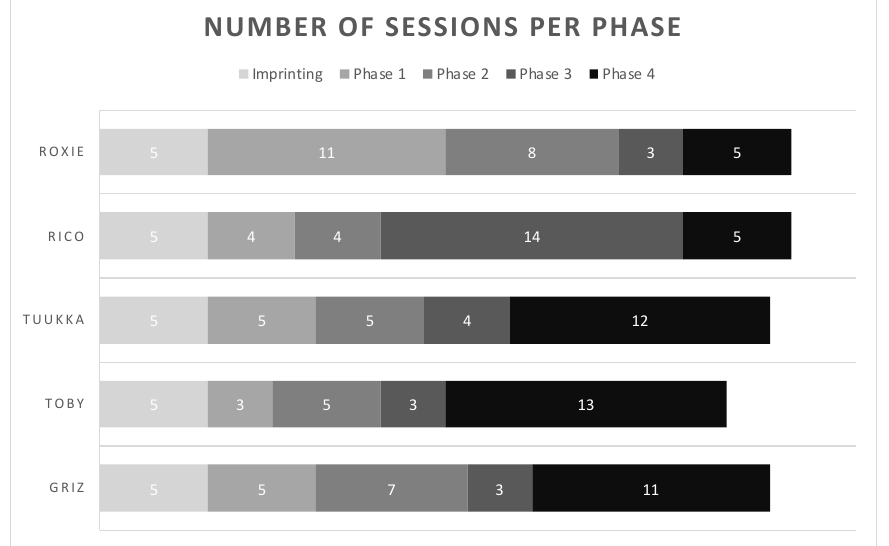
Figure 2. This graph shows the number of sessions each dog spent in each phase of training prior to the test phase. After imprinting, dogs had to spend a minimum of 3 sessions in each phase to meet the benchmark of 5/6 correct alerts on COVID-19 positive samples and 10/12 correct passes on COVID-19 negative samples.